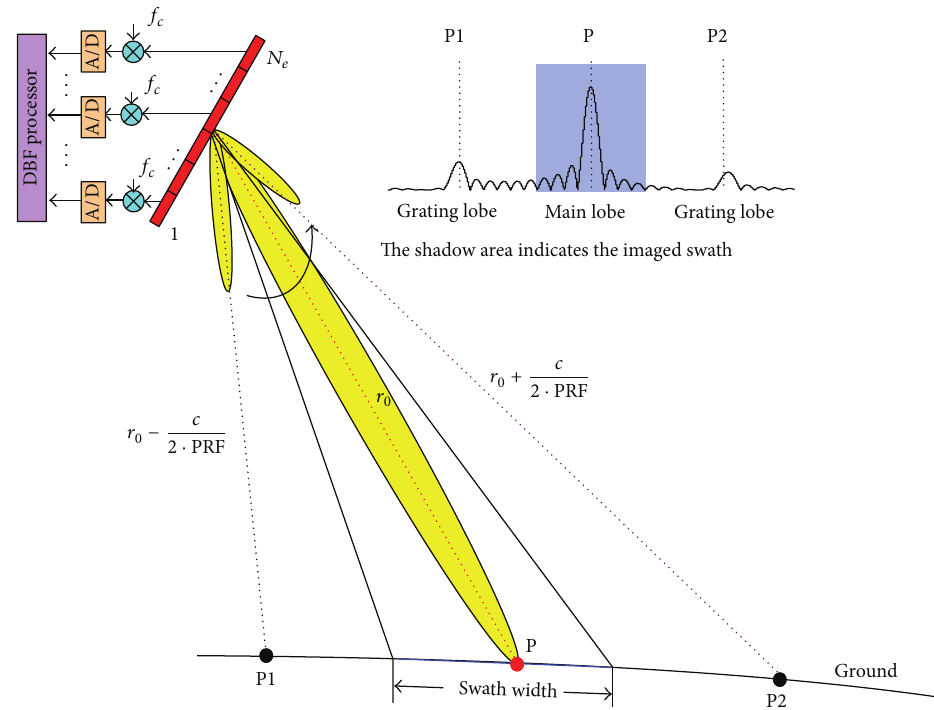
Figure 2: Graphic explanation of range ambiguities received by grating lobes during pulse